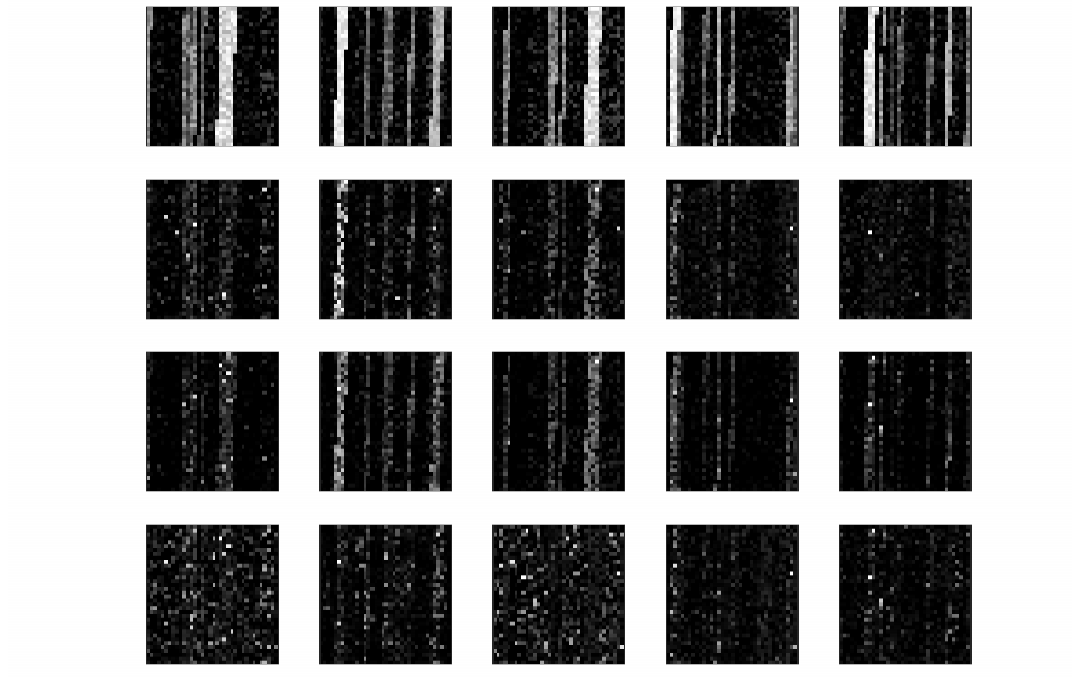
Figure 5. Abundance estimation errors with simulated data with 5 endmembers (SNR = 50 dB). The first row shows the ground truth abundances for the 5 classes. From the top, then the error in abundances as estimated by the hybrid, VCA and GBM methods,